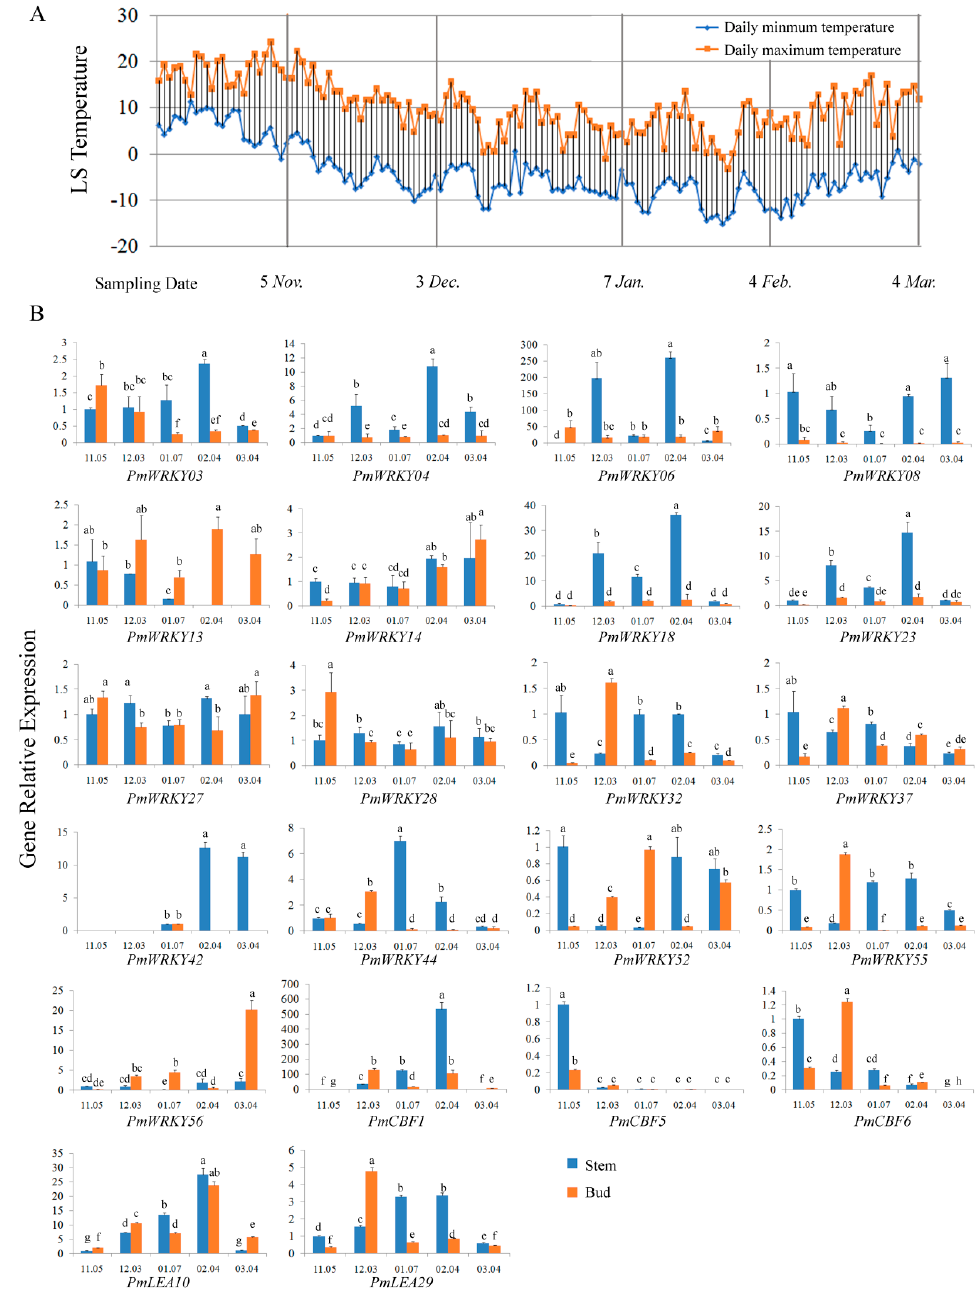
Figure 8 . Expression patterns of 17 selected PmWRKY genes in winter. ( A ) The daily land surface temperature near the sampling sites in winter from the date 12 October, 2017 to 4 March , 2018. ( B ) The expression patterns of PmWRKYs , PmCBFs and PmLEAs in winter by qRT-PCR using Actin as reference gene. Different letters indicate significant difference at level p = 0.05. Three independent experiments were performed with similar results.